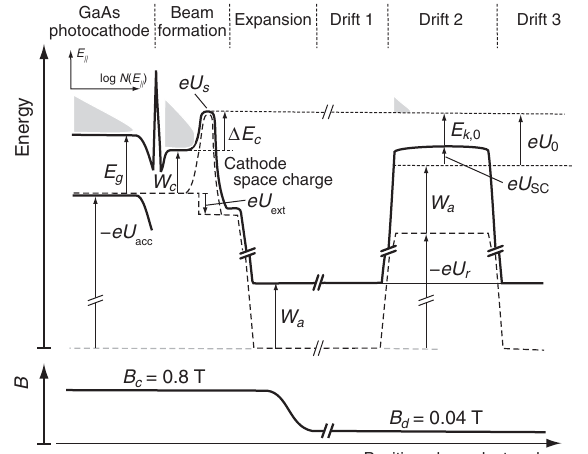
FIG. 2. Energy diagram along the electron track. The emission process at the GaAs photocathode is schematically indicated, illustrating the energy gap E in the semiconductor and energy g distributions of the electrons (gray shaded areas). The work function of the drift tube is denoted by W and the cathode work a FIG. 3. Deceleration curve of an 8 - μ A electron beam for an function by W . The electrons are extracted over a potential ¼ − 20 V. The curve breaks at U ¼ c accelerating voltage of U r acc barrier of height Δ E . In addition to the voltages defined in Fig. 1, − 16 . 12 V retarding voltage. Profile A, measured 50 mV before c U denotes the potential at the virtual electron source in front of ¼ − 16 . 8 V, s the break, is still flat. In profile B, measured at U r the cathode, U 0 the effective accelerating voltage (see the text), the current density in the beam center is strongly reduced and U the space charge voltage of the electron beam in the SC through the enhancement of the space charge in this area. The deceleration drift tube. The magnetic field strength B along the ¼ 4 . 5 μ A and I ¼ 1 . 2 μ A, two lower curves (starting near I f f electron beam axis is also shown. respectively) demonstrate how the breaking points (arrows) shift when the decelerated current is reduced. The viewing areas of the beam profiles are 20 mm × 20